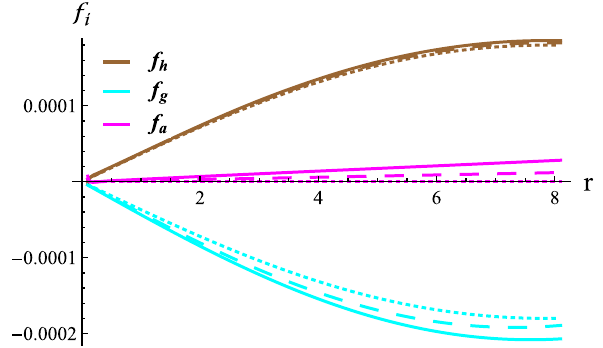
Fig. 8 Plots of hydrostatic equilibrium with χ = 0 ( dotted ) , 0 . 3 ( dashed ) , 0 . 5 ( solid ) for solution